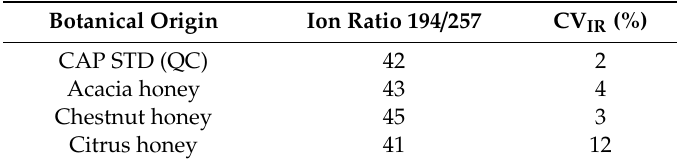
Table 2. The ion ratios 194/257 of [M − H] − 35 Cl-atomsand tolerance ion ratio (CV IR %) in honey samples from different botanical origin spiked at 0.3 µg/kg.